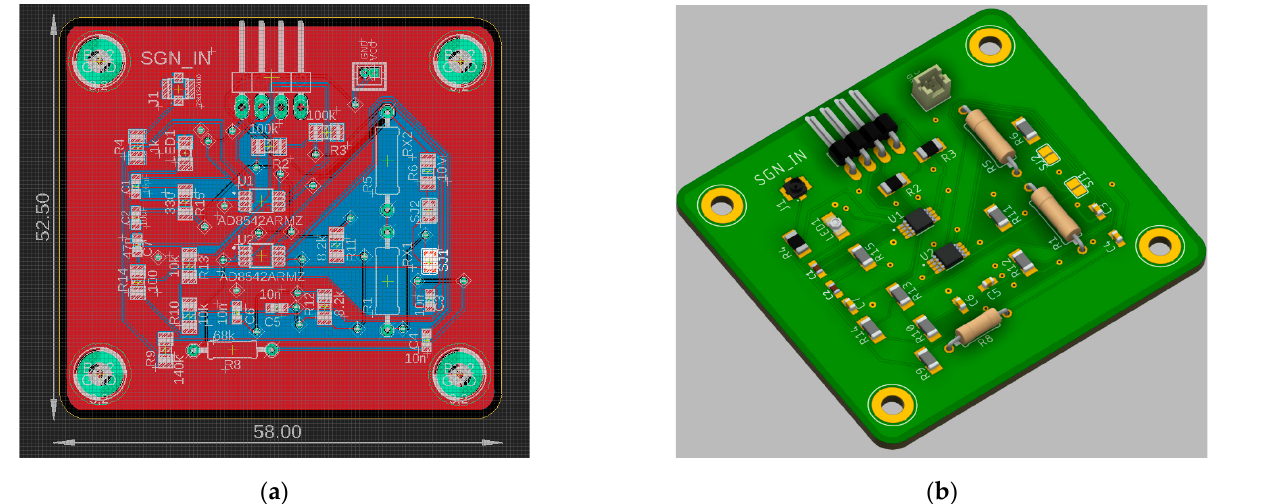
Figure 27. PCB board of the overall conditioning section ( a ) and 3D model view ( b ). Figure 28. Three flexible AlN sensors used in the preliminary tests: triangular tip ( a ), large rec- tangular ( b ), and small rectangular ( c ).